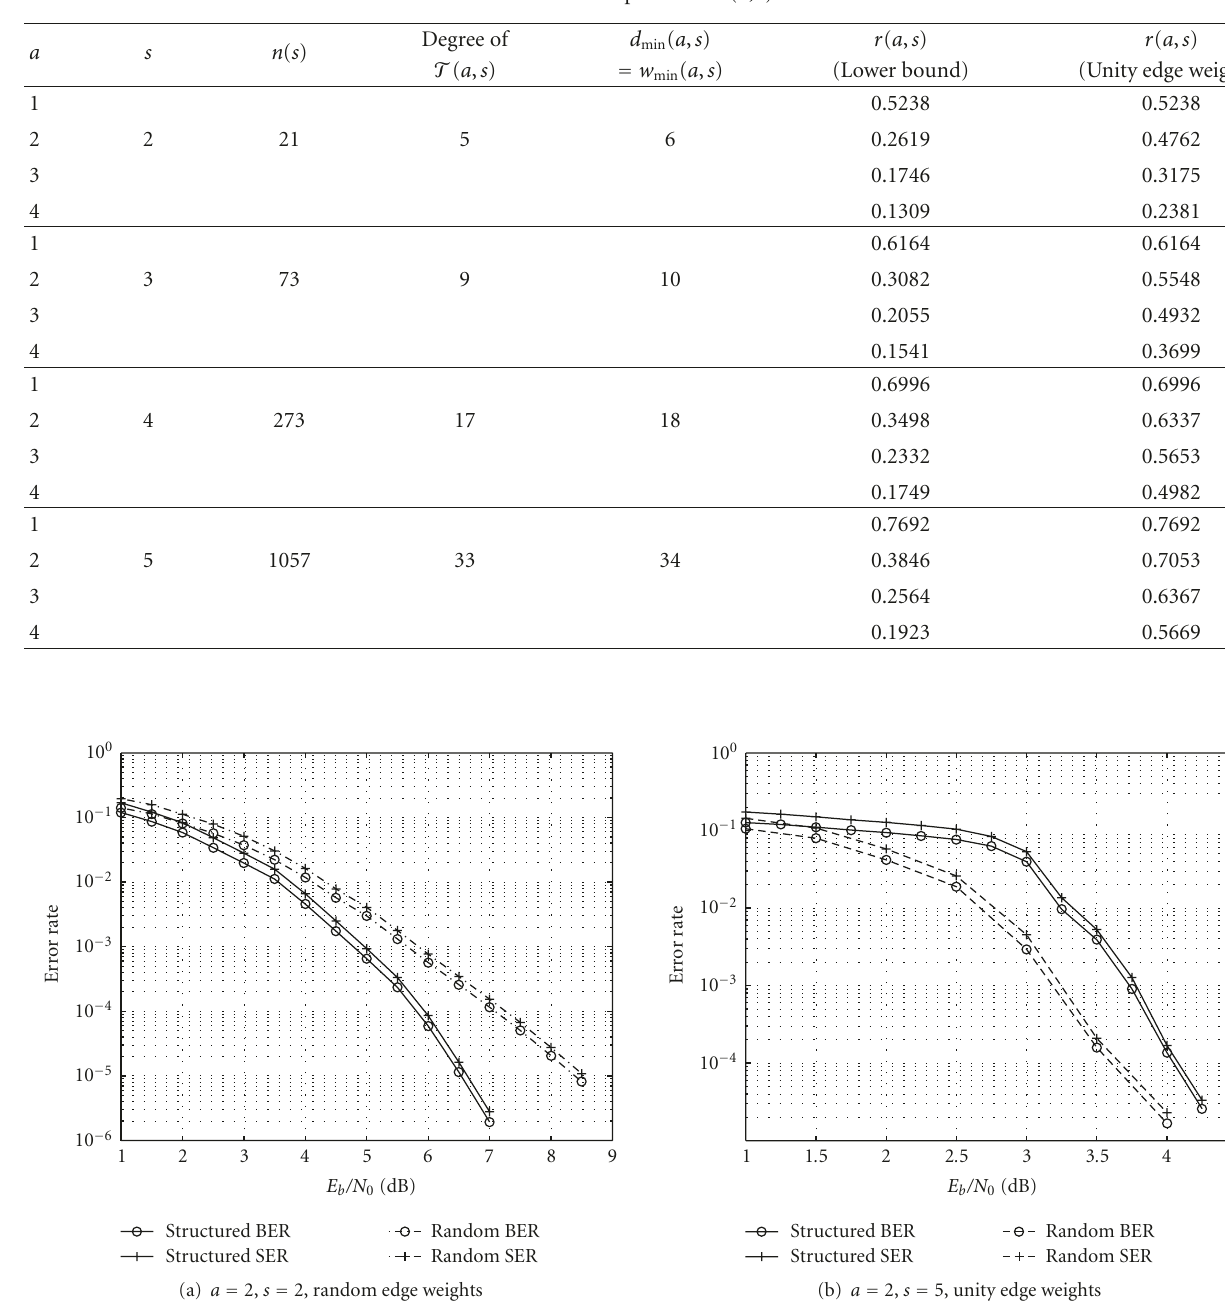
Figure 3: Performance of structured and random LDPC codes over Z 4 with QPSK signaling over the AWGN